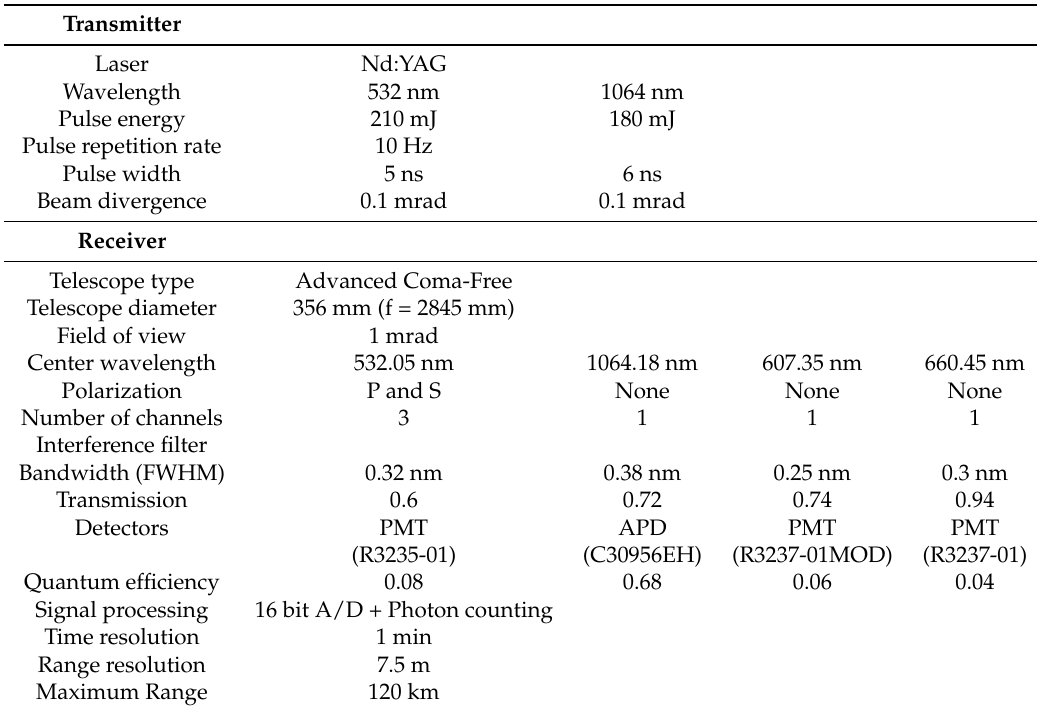
Table 1. Characteristics of GOSAT-2